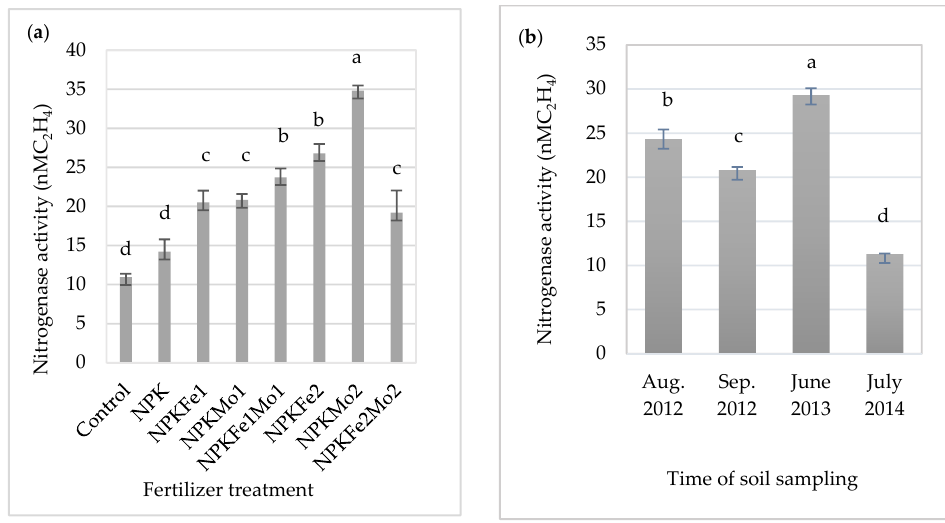
Figure 1. The effects of mineral fertilizer treatment ( a ) and the time of soil sampling ( b ) on nitrogenase activity. Each bar represents the mean ± SE. The same letters mark no significantly different values ( p ≤ 0.05).